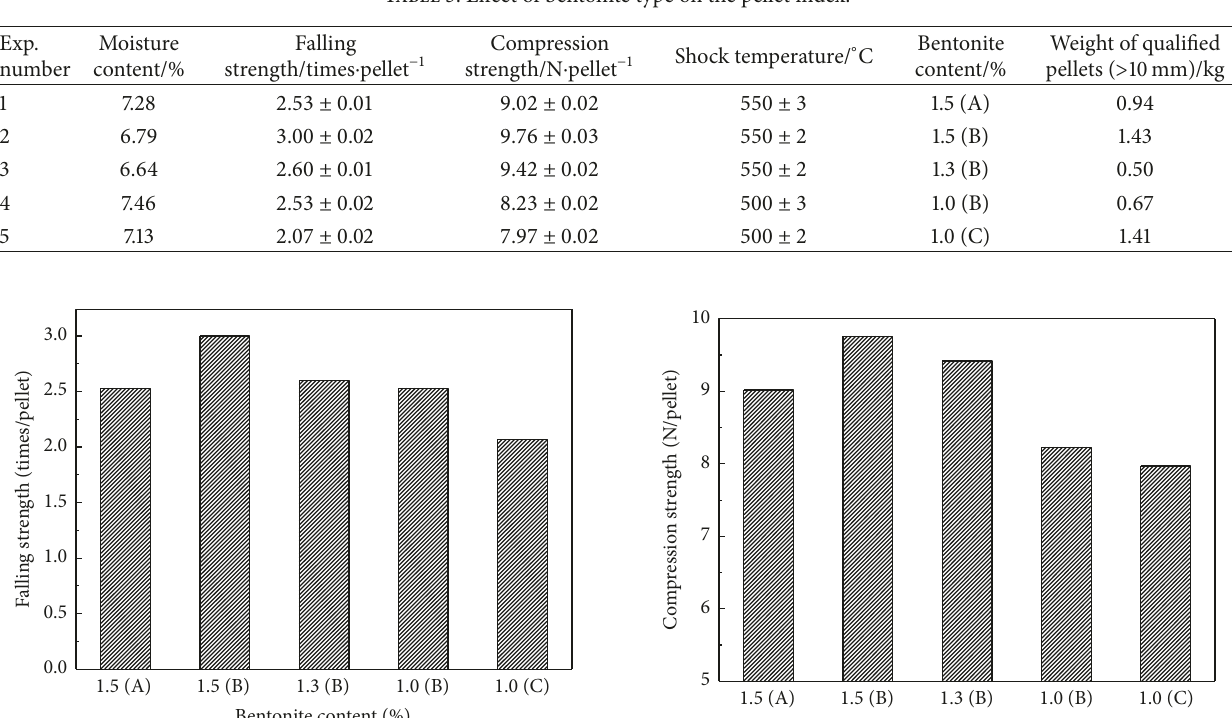
Table 3: Effect of bentonite type on the pellet index.